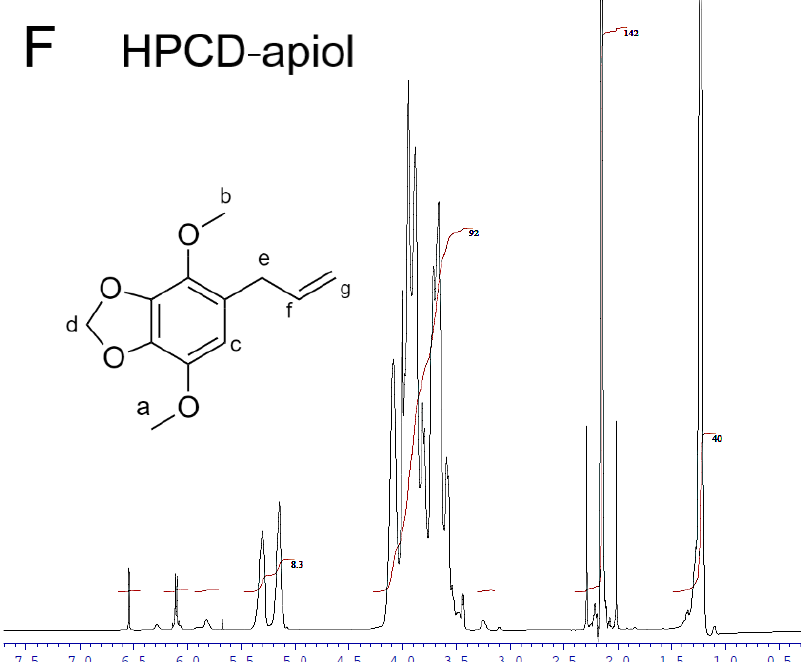
Figure 3. 1 H NMR-spectra (D 2 O, 600 MHz) of MCD ( A ), MCD-EG, molar ratio 2:1 ( B ), MCD-Lev-EG, molar ratio 4:1:1 ( C ). ( D ) Proposed structure of MCD inclusion complexes with EG, apiol, Lev. 1 H NMR-spectra (D 2 O, 500 MHz) of HPCD ( E ), HPCD-apiol, molar ratio 2:1 ( F ). a lesser extent for HPCD having hydrophilic substituents, which causes induced chemical Table 2. 1 H-chemical shifts corresponding to MCD and HPCD in the presence and absence of EG, apiol and mixture of EG-Lev. 1 H-chemical shifts corresponding to EG and Lev in the presence and absence of MCD and HPCD in comparison with literature data for EG and Lev alone [35,41]. D 2 O, 600